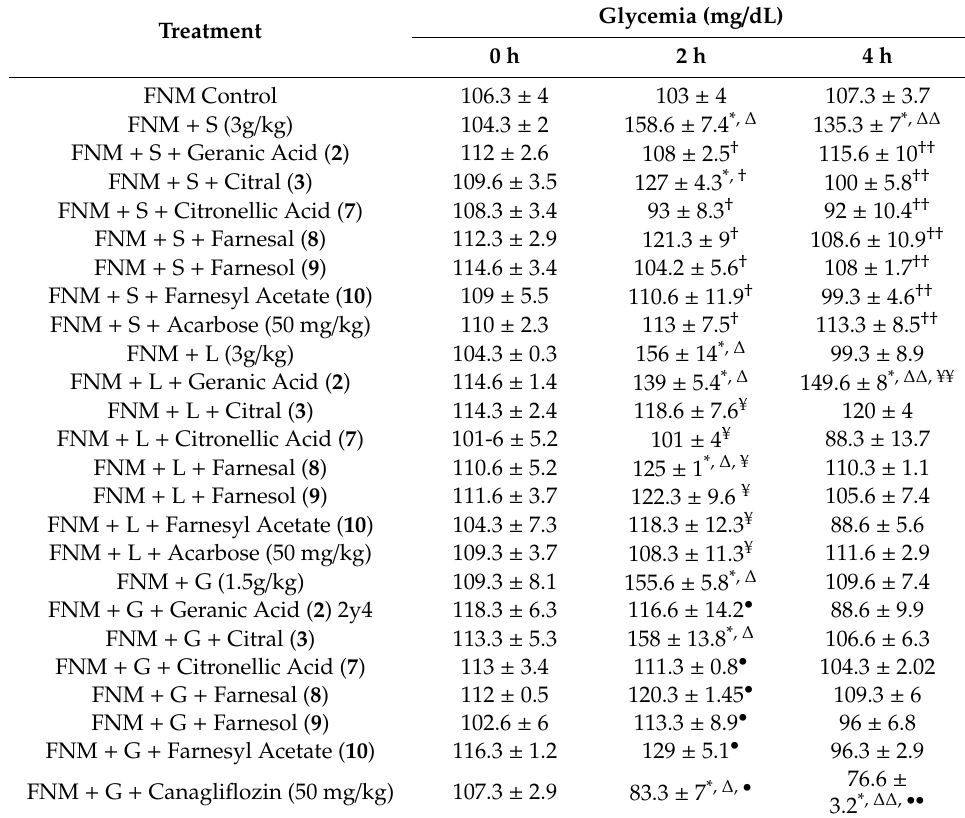
Table 2. E ff ect of terpenes on oral sucrose, lactose, and glucose tolerance tests.